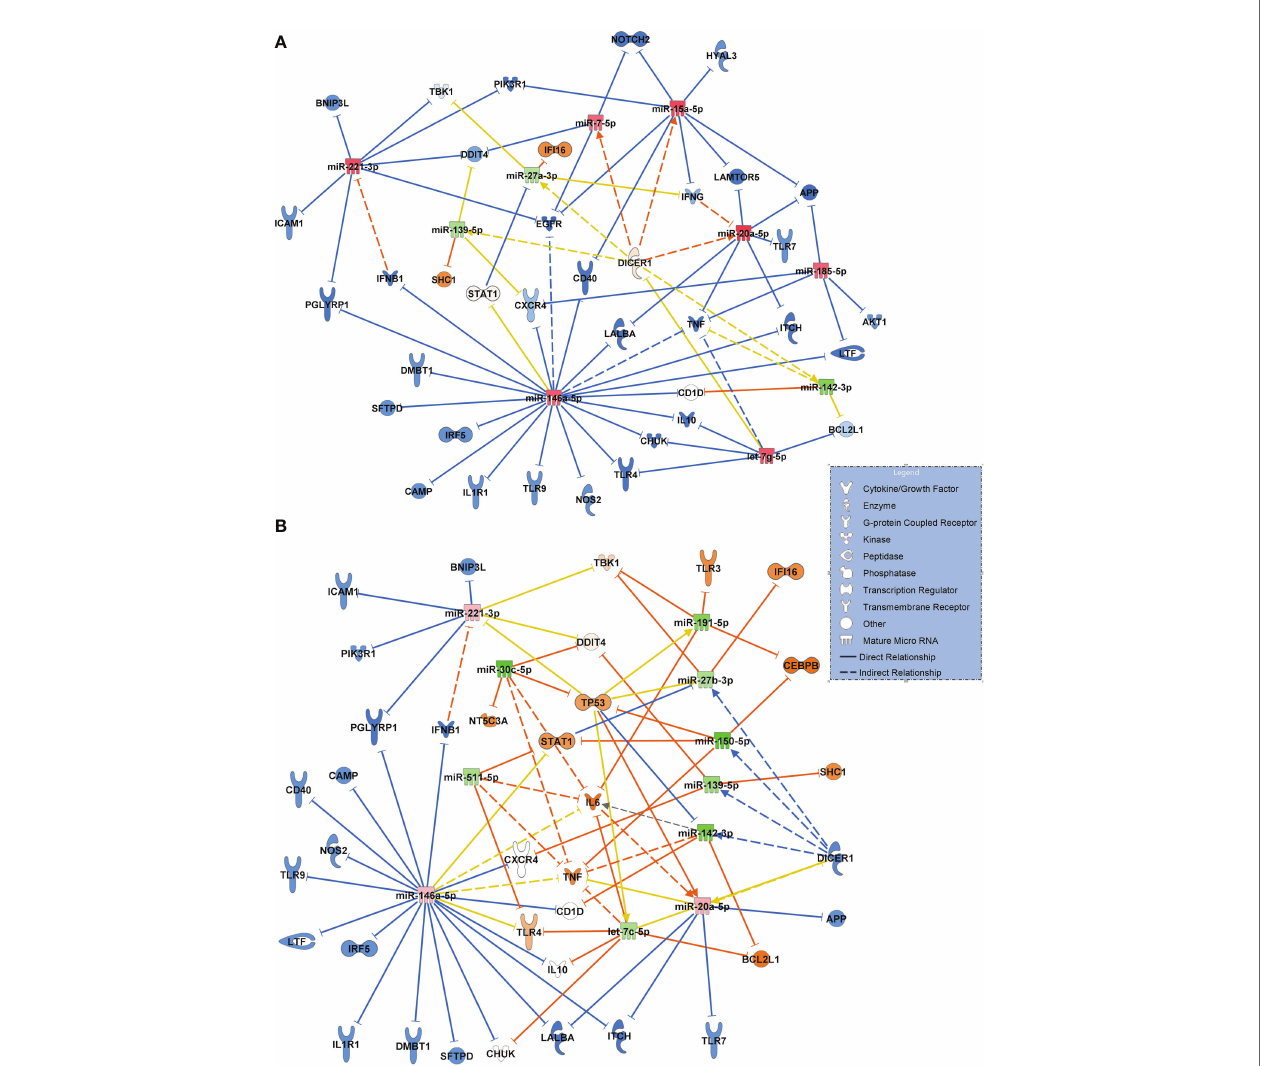
FIGURE 8 | (A) Signaling network comparing miRNA expression values and their target regulation between patients with community acquired pneumonia of bacterial origin (n=12, baseline) and patients with COVID-19 pneumonia (n=15). (B) Network resulting from a comparison between patients with sepsis induced lung injury of bacterial origin (n=28, baseline) and patients with COVID-19 ARDS (n=15) at admission to the ICU (day 0 of treatment). Downregulated miRNAs are shown in green and the corresponding mRNA targets in orange colour. Upregulated miRNAs are marked in red and their inhibited targets in blue. For miRNA target scanning, data were fi ltered for antimicrobial response and lung as an organ system and con fi dence levels were set to experimentally observed. Yellow lines and non-coloured molecules indicate undetermined regulatory effects because the transcripts were targeted by miRNAs with different directions of regulation. Solid lines indicate direct and dashed lines indirect relationships. The legend inserted into the graph illustrates the type of target molecules according to the symbols used in the